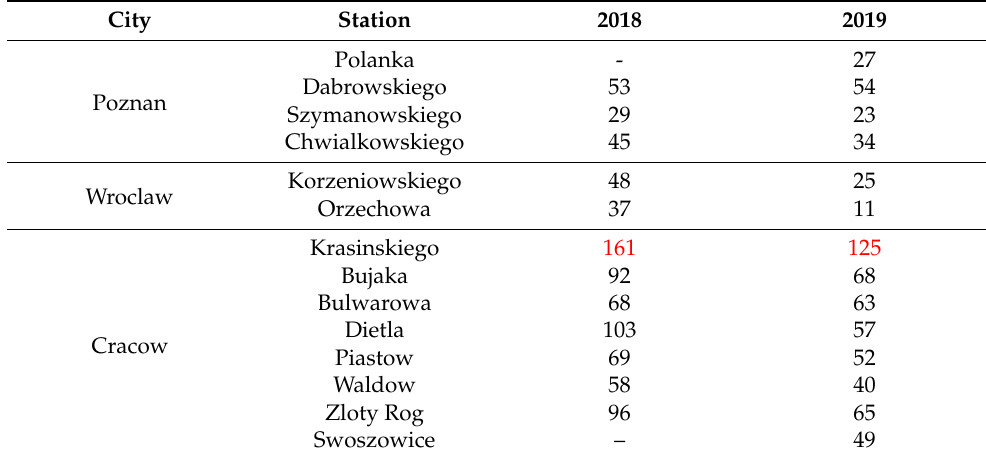
Table 5. Number of cases when the acceptable level was exceeded in Polish cities